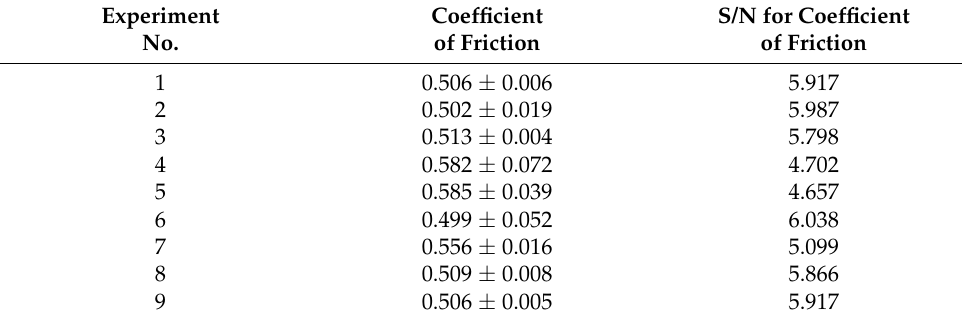
Table 12. Results of Taguchi experiment for friction coefficient tests.